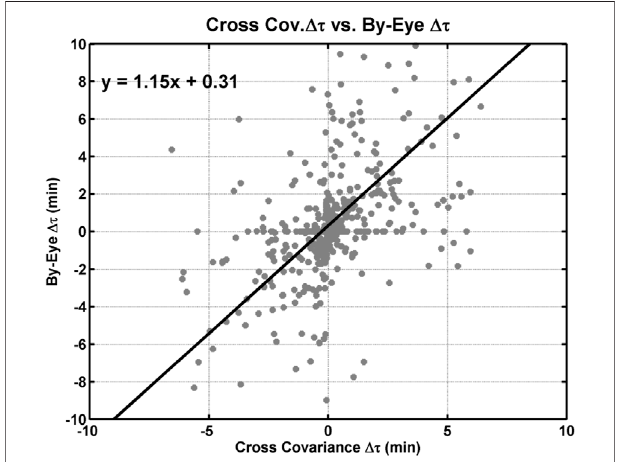
FIGURE12| Formatofthis fi gureisthesameas Figure6 ,exceptforthis fi gure we have used the southern and northern hemisphere onsets identi fi ed by-eye to determine the difference in onset time and excluded differences in onset time equal to 0 s.